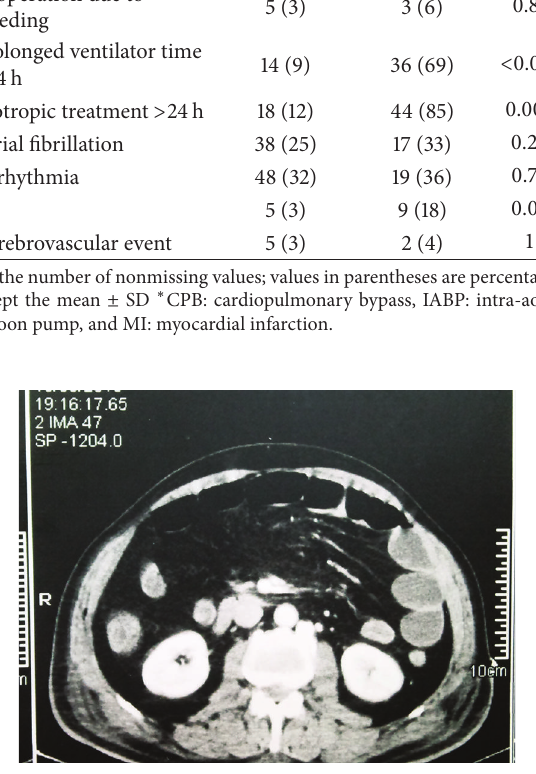
Figure 1: Thickened bowel walls and dilated fluid-filled bowel loops of an AMI patient on an abdominal CT image. AMI: acute mesenteric ischemia; CT: computerized tomography.